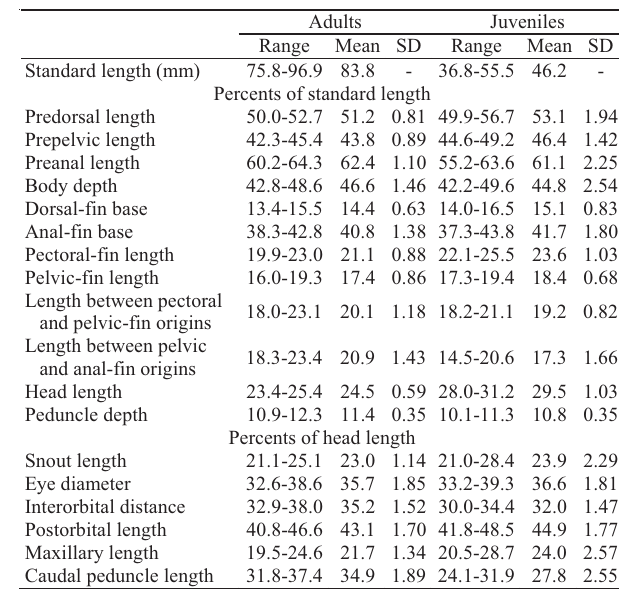
Table 1. Morphometric data of 28 specimens of Astyanax erythropterus. Adults: n = 18 (5 males, 13 females), juveniles: n = 10. Morphometric differences between juveniles and adults were statistically significant for all attributes ( t -Test; p < 0.05). SD = Standard deviation.